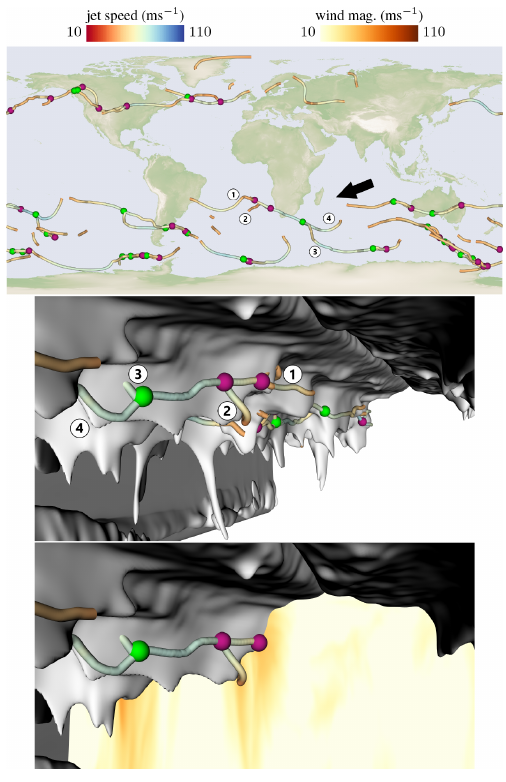
Figure 13. Top: overview visualization of split (green) and merge (purple) events of jet stream core lines at the tropopause. An arrow depicts the camera position of the 3-D views shown from below the tropopause. Middle: a jet (1) moves along a tropopause fold and another jet that passed from below the tropopause fold merges into it (2). The combined jet later splits into two separate branches (3) and (4). Bottom: an orthographic slice color codes the wind magnitude, showing that the jets pass through orange regions (high wind speed). The data here are for 9 September 2016 at